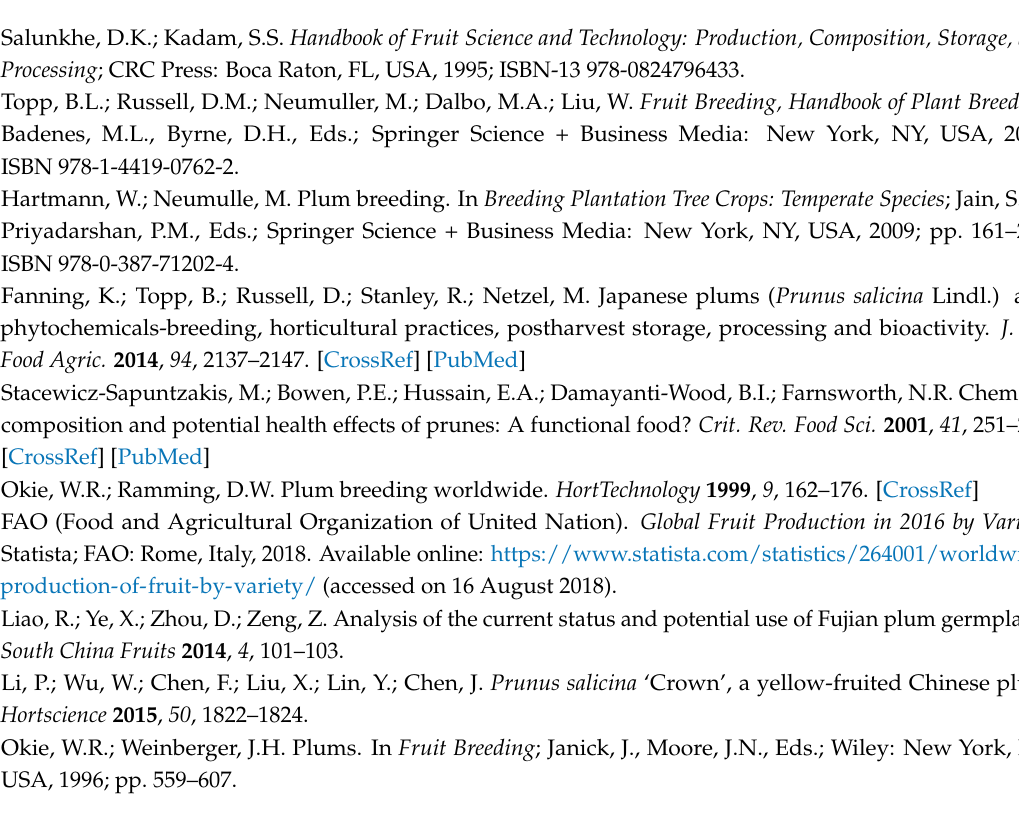
Figure S1: ISSR profiles of 33 plum varieties produced by the UBC811 primer, Table S1: Analysis of molecular variance (AMOVA) of 33 plum varieties based on two regions (Gutian and Yongtai), Table S2: Analysis of molecular variance (AMOVA) of 33 plum varieties based on their origins (China, Japan, and the